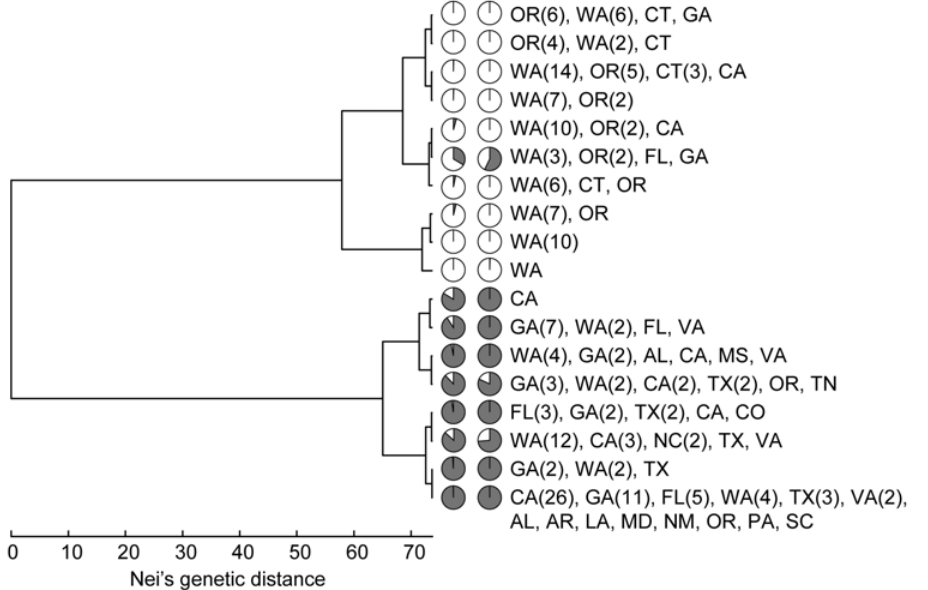
Figure 5. Comparison of the genetic groups identified by three clustering algorithms. The UPGMA dendrogram was produced for the 18 clusters identified by BAPS 5.2. The membership of each cluster is indicated to the far right by state, with the number of isolates if greater than one in parentheses. Pie charts show the group assignment of the isolates in each BAPS cluster by Structure 2.2 (left) and k-means clustering (right). See Table 1 for state